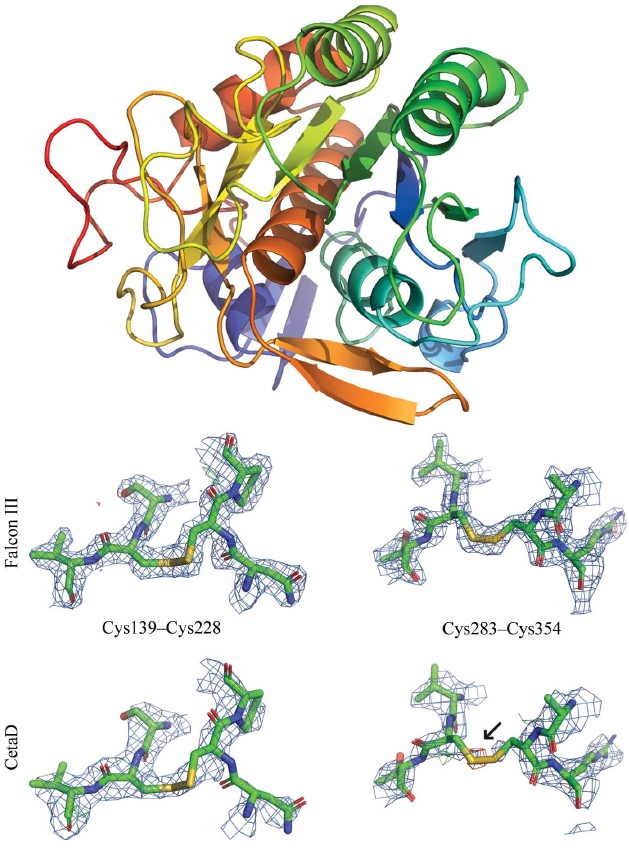
Figure 2 The structure of proteinase K determined from Falcon III data and the density around its two disulfide bonds for the considered cameras. The density around the two disulfide bonds indicates increasing radiation damage as an effect of increasing dose. The positive difference density around C (cid:3) of Cys283 in the CetaD data (black arrow) indicates a partially dislocated S atom. The 2 mF o (cid:4) DF c densities (blue meshes) are contoured at 1.5 (cid:2) above the mean; mF o (cid:4) DF c difference densities (green/red meshes) are contoured at (cid:8) 3 (cid:2) around the mean. All meshes were carved to 2 A˚ around the selected atoms in PyMOL (Schro¨dinger;